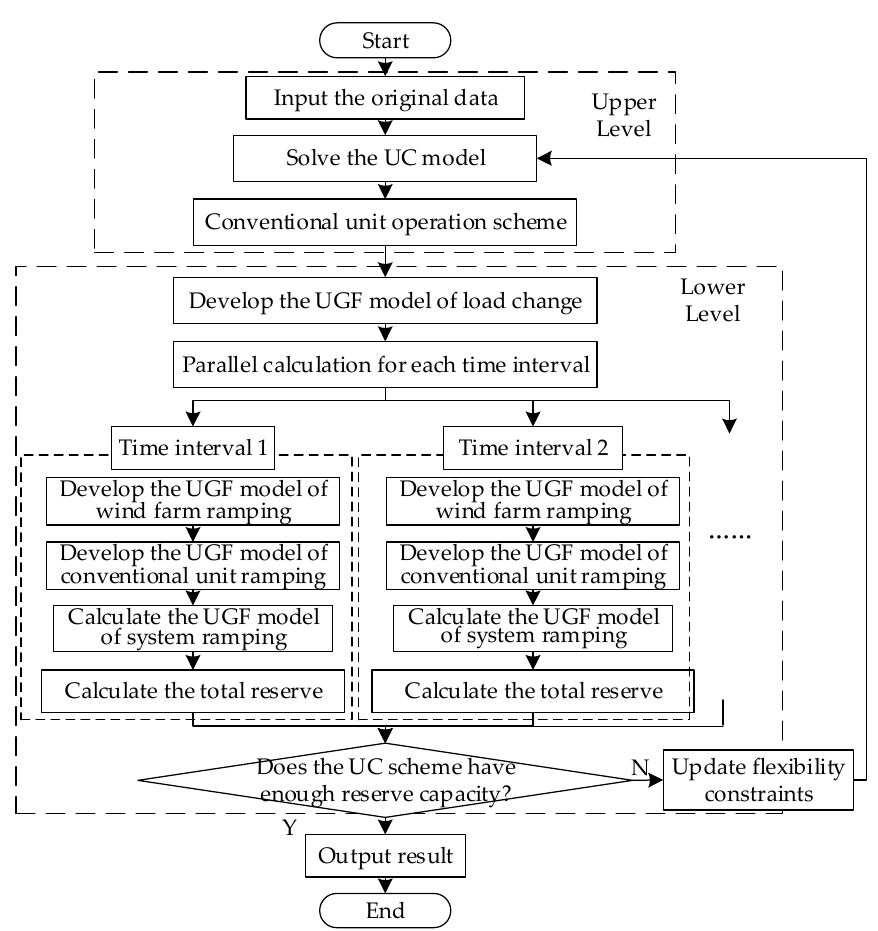
Figure 2. Flowchart of flexibility based day-ahead generation–reserve bilevel decision model.